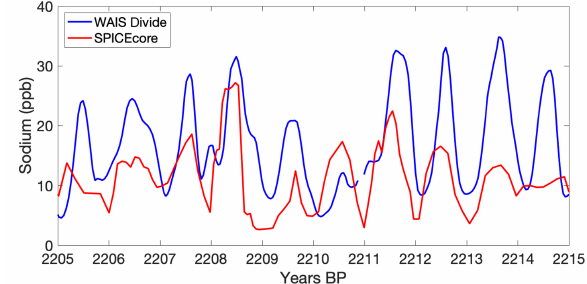
Figure 4. Annual layering of sodium in WAIS Divide (blue; Sigl et al., 2013) and SPICEcore (red). Annual layers in sodium are clear in both records but are more pronounced at WAIS Divide for most years.